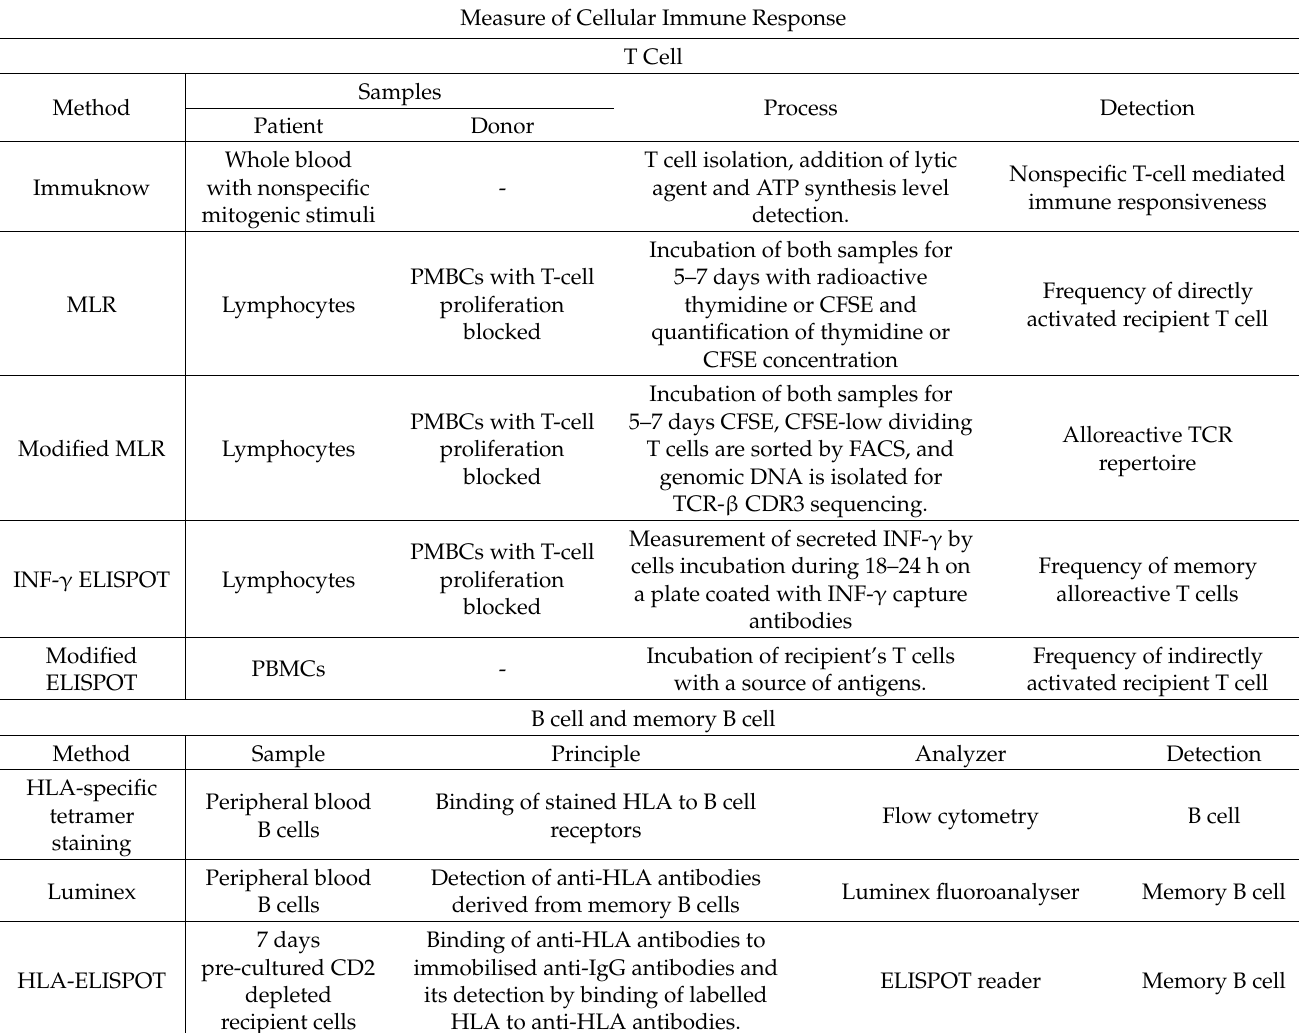
Table 2. Methods to measure the cellular immune